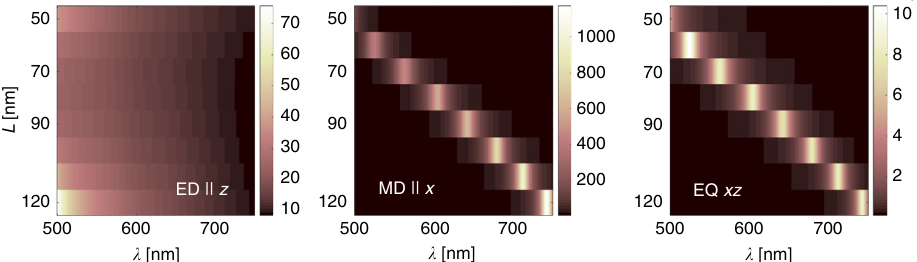
Fig. 2 Total decay rate enhancement factors F for different optimally oriented multipolar sources . The total rate includes radiative and absorptive tot contributions for an electric dipole parallel to the z axis, a magnetic dipole parallel to the x axis, and an off-diagonal electric quadrupole in the xz plane. The enhancement is presented in function of free-space wavelength λ of the source and for some discrete nanoantenna patch sizes L